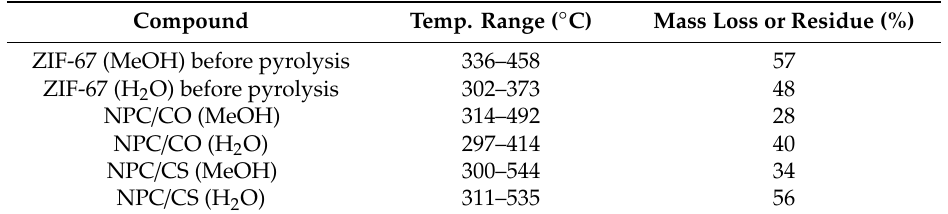
Table 1. TGA thermal analysis of ZIF-derived nanoporous carbon and cobalt oxide/sulfide-based materials.